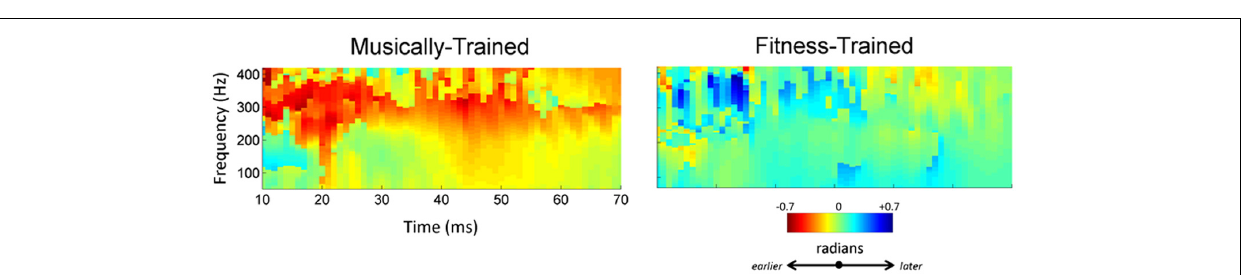
FIGURE 3 | Pre-test and post-test waveforms in musically trained and fitness-trained groups. Grand average neural responses for the musically trained (red) and fitness-trained (black) groups at pre-test and post-test, displayed across the entire subcortical response (top) and at a single response peak (bottom).